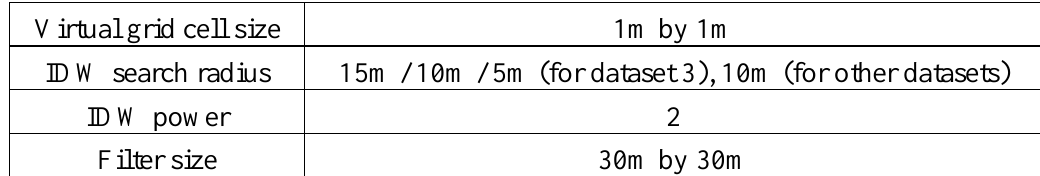
Table 3. Experimental